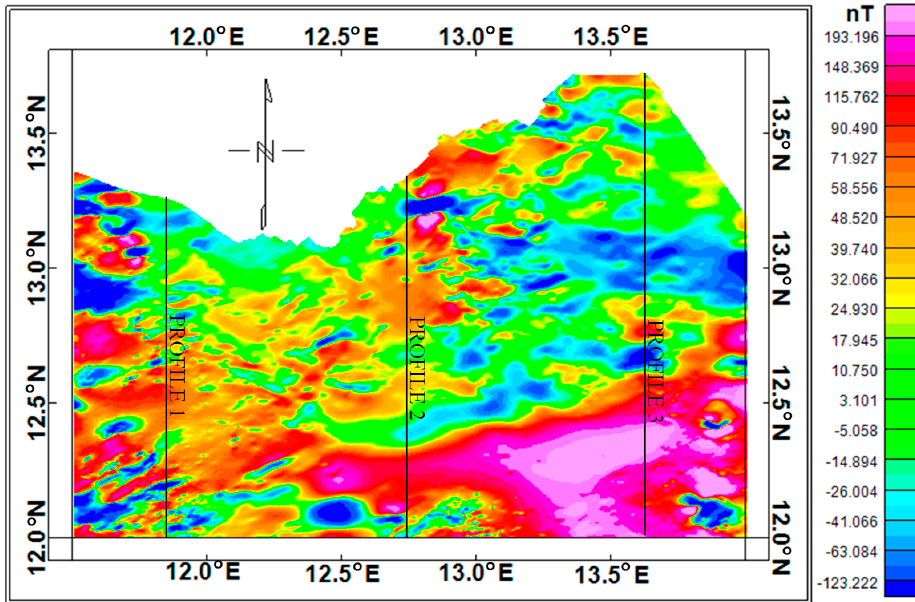
Figure 3. Total magnetic intensity map with the profile lines used for modelling.